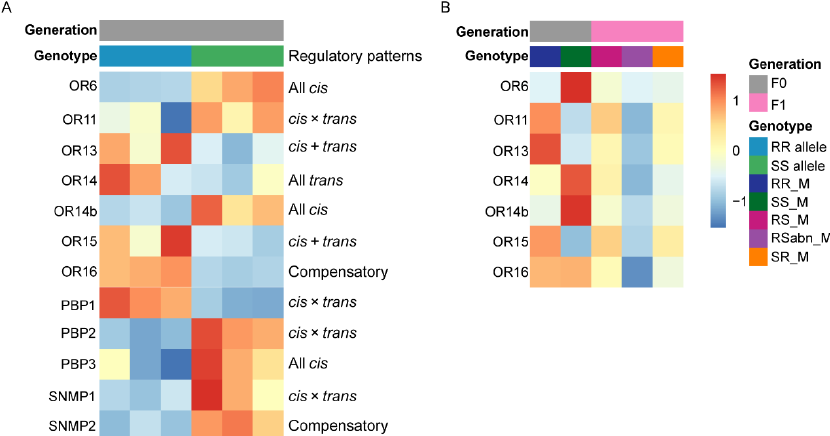
Figure 6. Expression patterns and regulatory patterns of pheromone perception related genes. ( A ) Heatmap displays the mean expression level of the ASE of pheromone receptor, pheromone binding protein and sensory neuron membrane protein genes for the three libraries in RS_M. Alleles of different origin are distinguished by different colors. The figure also shows the regulatory patterns of pheromone perception-related genes. ( B ) Heatmap displaying the pheromone receptor gene expression level for each genotype (RR_M, SS_M, RS_M, RSabn_M and SR_M) among the three libraries. Different parents and F 1 hybrids are distinguished by different colors.